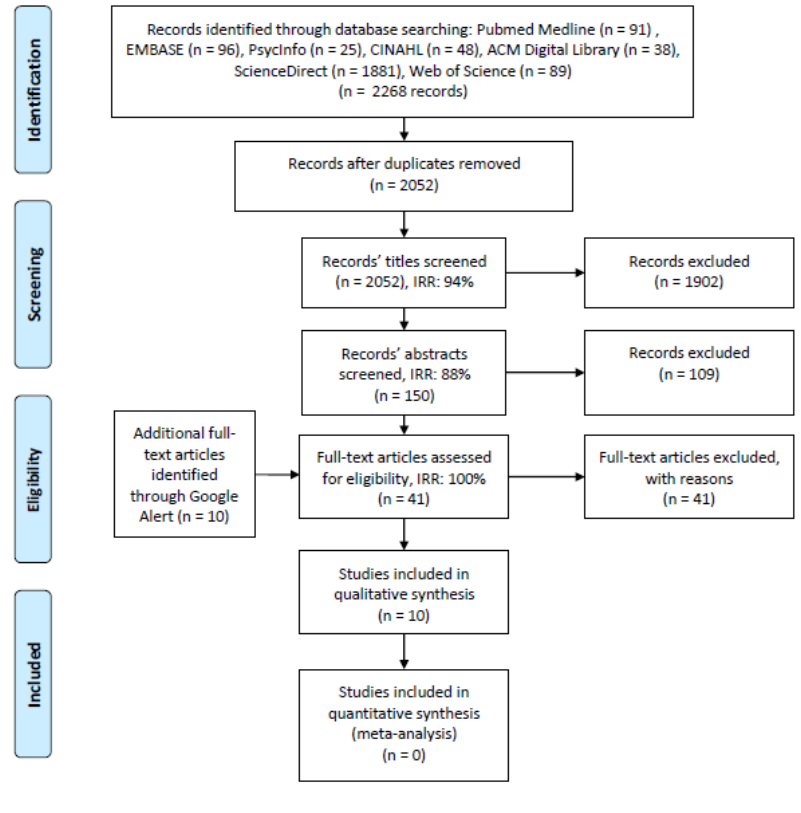
Figure 1. Preferred Reporting Items for Systematic Reviews and Meta-Analyses flow diagram of included studies. Search updates were conducted until April 2020, with no additional papers being identified for inclusion. IRR: interrater